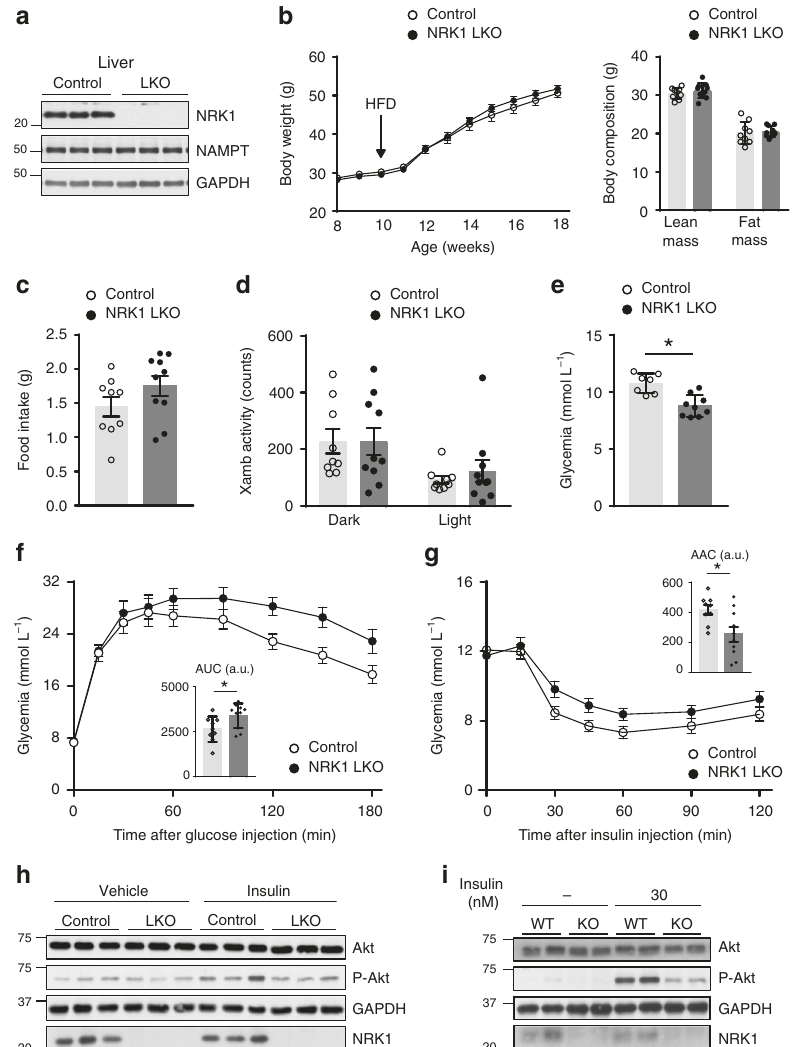
Fig. 2 Liver-speci fi c NRK1 de fi ciency exacerbates diet-induced insulin resistance. a Validation of NRK1 deletion and protein level of NAMPT and GAPDH in liver homogenates from NRK1 LKO and control (Ctrl) mice. b Body weight and body composition of NRK1 LKO ( n = 10) and control ( n = 9) mice on high-fat diet (HFD) at the indicated ages. c , d Food intake c and locomotor activity d of NRK1 LKO ( n = 9) and control ( n = 8) mice on HFD at 18 weeks of age. e Glycemia levels after 6h-fasting in NRK1 LKO ( n = 9) and control ( n = 7) mice on HFD at 24 weeks of age. f , g Blood glucose level during intraperitoneal glucose ( n = 8 mice in the control group, n = 10 mice in the NRK1 LKO group) f and insulin g tolerance test in NRK1 LKO and control mice on HFD ( n = 9 mice for the control group, n = 10 mice for the NRK1 LKO group) at 20 and 22 weeks of age, respectively. h Protein level of Akt, P-Akt, GAPDH, and NRK1 in the liver of NRK1 LKO and Ctrl mice on HFD 15 min after insulin injection (1U kg − 1 ) ( n = 3 mice per group). i Protein levels of Akt, P-Akt, GAPDH and NRK1 in primary hepatocytes from NRK1 KO and WT mice stimulated with insulin at the indicated concentration. Results shown are mean ± SEM, * indicates statistical difference vs the respective control value at p < 0.05. The individual values and statistical tests used for each panel can be found in the Source Data fi